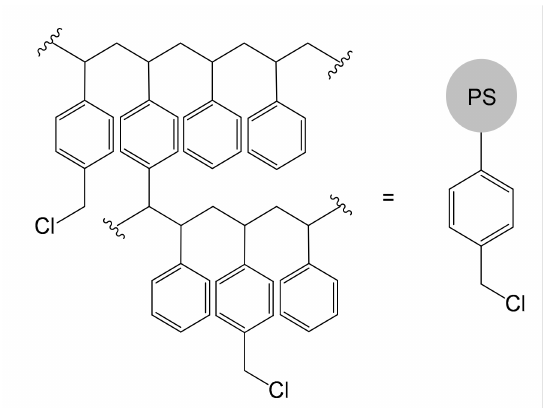
Figure 10. Structure of the functionalized polymeric resin realized by Merrifield in 1963 [70]. Recently, Basu’s group immobilized an iron catalyst by exploiting a Merrifield resin functionalized with anthranilic acid (Figure 11) [72]. The resulting [Fe II (Antra-Merf)] cata- lyst constitutes a green, simple and low-cost solution for the synthesis of carbamates and N -substituted ureas. The catalyst immobilization process took place in four steps. Initially, 4-hydroxybenzaldehyde was added dropwise to a suspension of the Merrifield resin in DMF. The hydroxyl group performed a nucleophilic substitution on the chloromethyl frag- ment of the resin. The product was isolated by filtration after having heated the mixture at 90 ◦ C for 12 h. Subsequently, anthranilic acid was added, leading to the formation of an imine bond and the product, by virtue of the anchorage to the resin, could be again isolated by simple filtration. Finally, the last step involved the addition of iron(II) chloride under nitrogen atmosphere in methanol, obtaining the immobilized catalytic species.